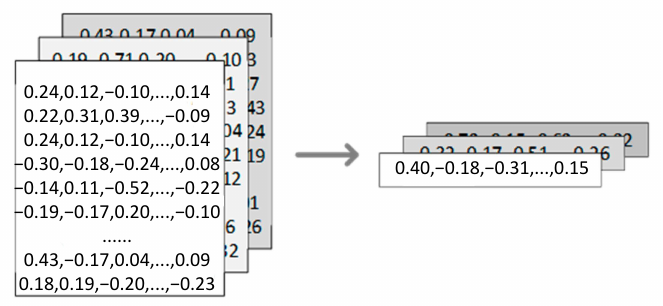
Figure 4. The hidden layer projects each m × N matrix into a 1 × N vector.